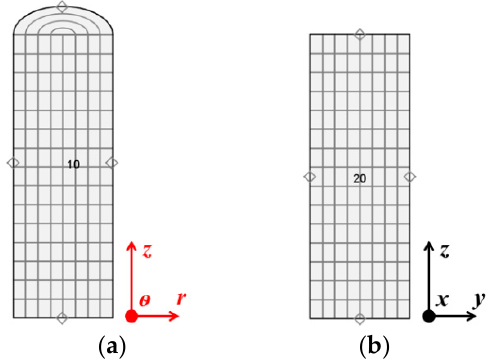
Figure 1. The CY-V ( a ) and CA-V ( b ) components.